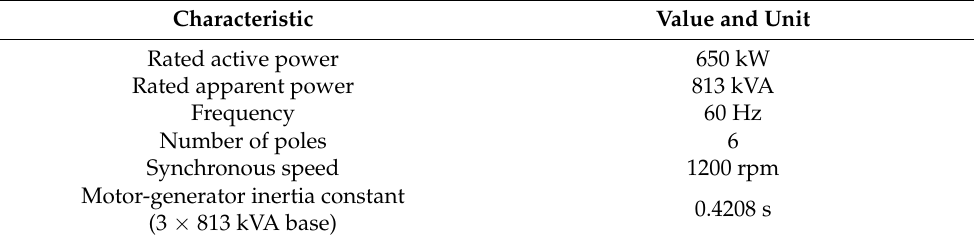
Table A1. Technical data of the diesel generator [26].